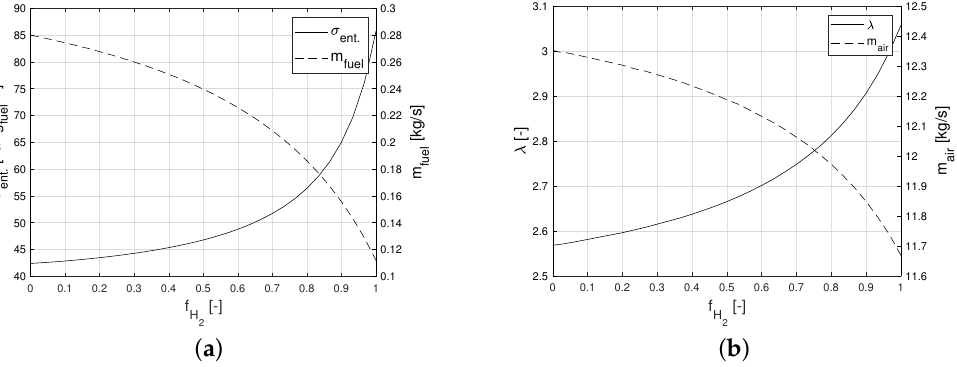
Figure 4. ( a ) Specific entropy destruction and hydrogen flow rate. ( b ) Air excess and air flow rate, depending on the hydrogen